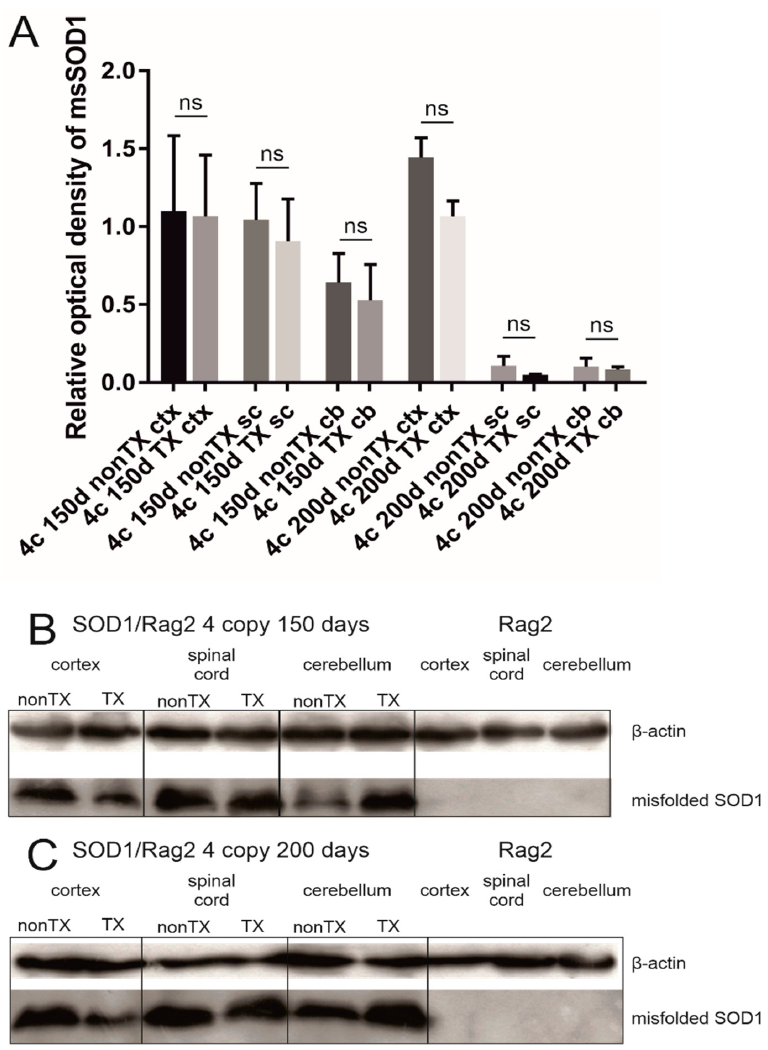
Figure 7. Western blot analysis revealed that there is no significant difference (ns) in the level of expression of misfolded SOD1 between transplanted (TX) and nontransplanted (nonTX) 4-copy hSOD1 animals (150 and 200 days old). Cortices (ctx), spinal cords (sc), and cerebella (cb) were analyzed separately. Rag2 mice are shown as a reference. Results were normalized to actin. The relative optical density of misfolded SOD1 in analyzed tissues ( A ). One-way ANOVA and Sidak’s tests were used with p < 0.05 considered statistically significant. Values are presented as mean ± SD. Representative blot from the 150 days mice group ( B ). Representative blot from the 200 days mice group ( C ). Sample size within the Rag2 control group: n = 5; SOD1/rag2 nontransplanted 4-copy group at 150 days: n = 5; SOD1/rag2 transplanted 4-copy group at 150 days: n = 5; SOD1/rag2 nontransplanted 4-copy group at 200 days: n = 5; SOD1/rag2 transplanted 4-copy group at 200 days: n = 5.